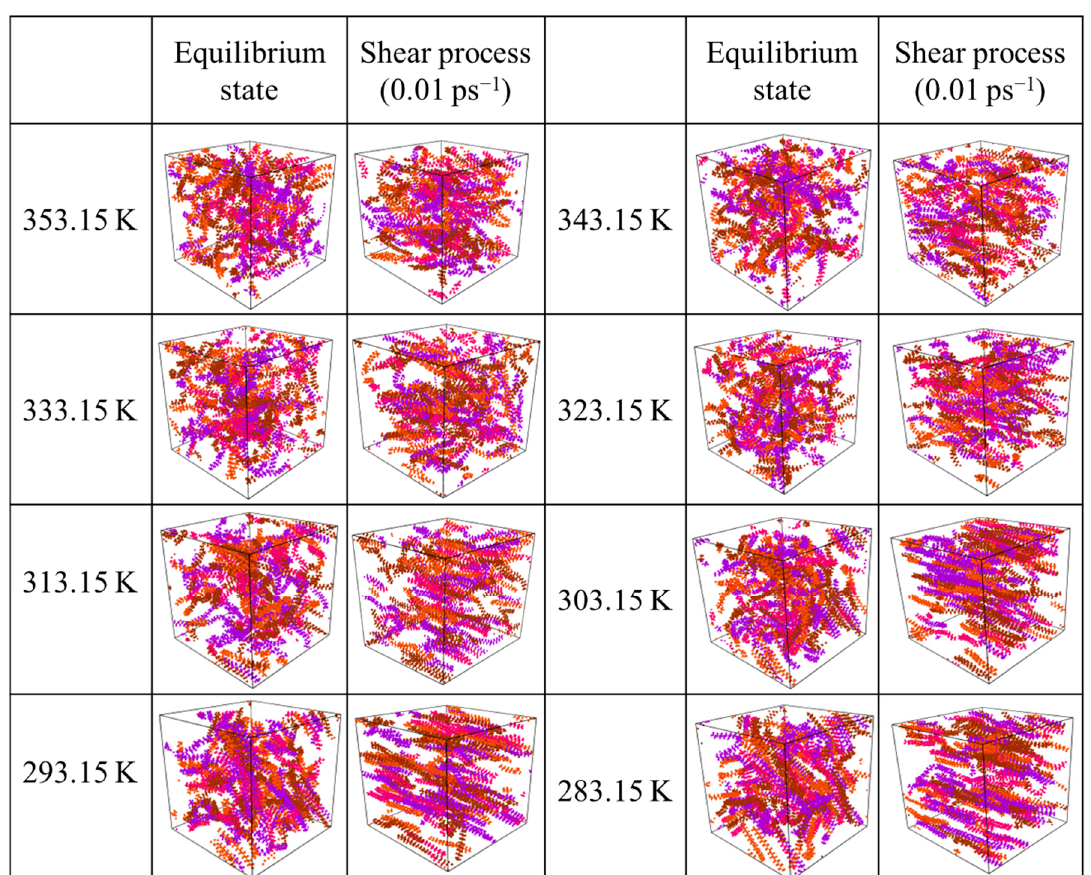
Figure 12. The distribution of final states of wax molecules in the equilibrium process and shear process with a shear rate of 0.01 ps − 1 at various temperatures.